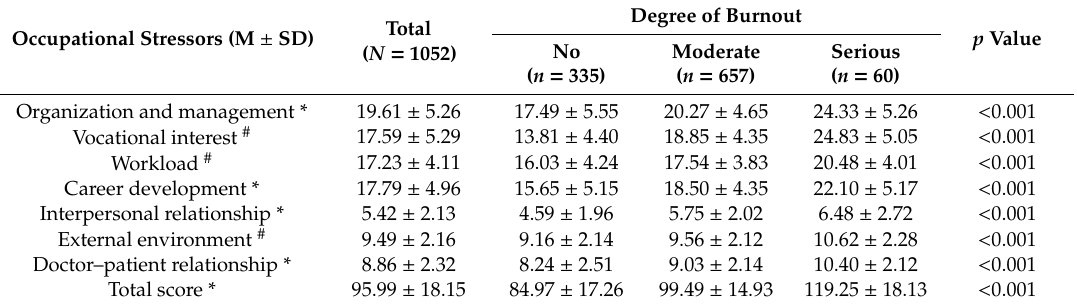
Table 2. Score of occupational stressors at di ff erent degrees of burnout among healthcare professionals.